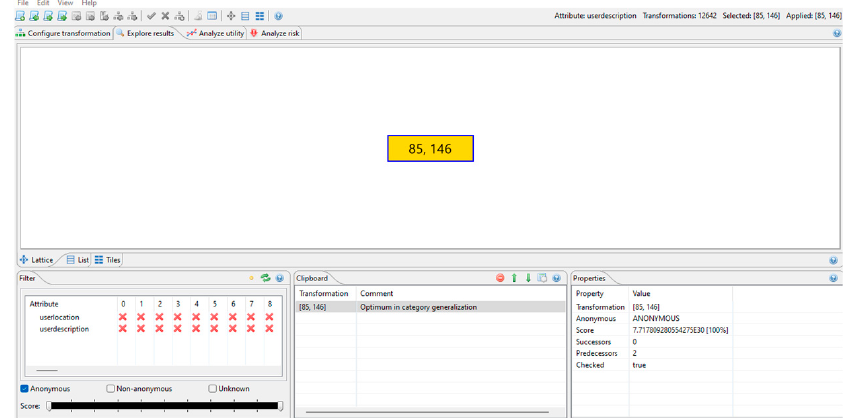
Figure 9. Anonymization graph solutions.